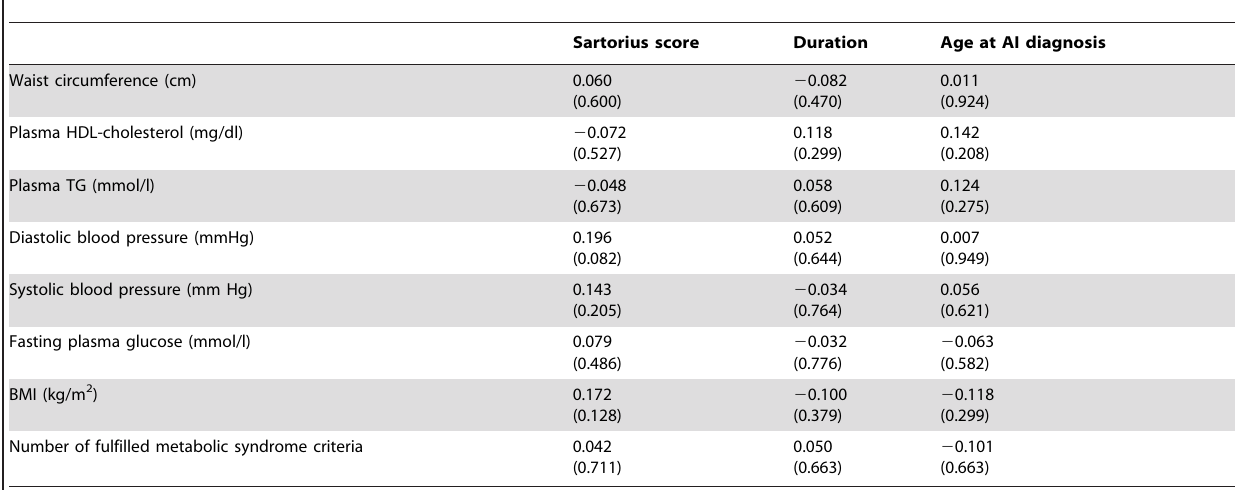
Table 2. Correlation of severity and duration of AI with parameters of metabolic syndrome.